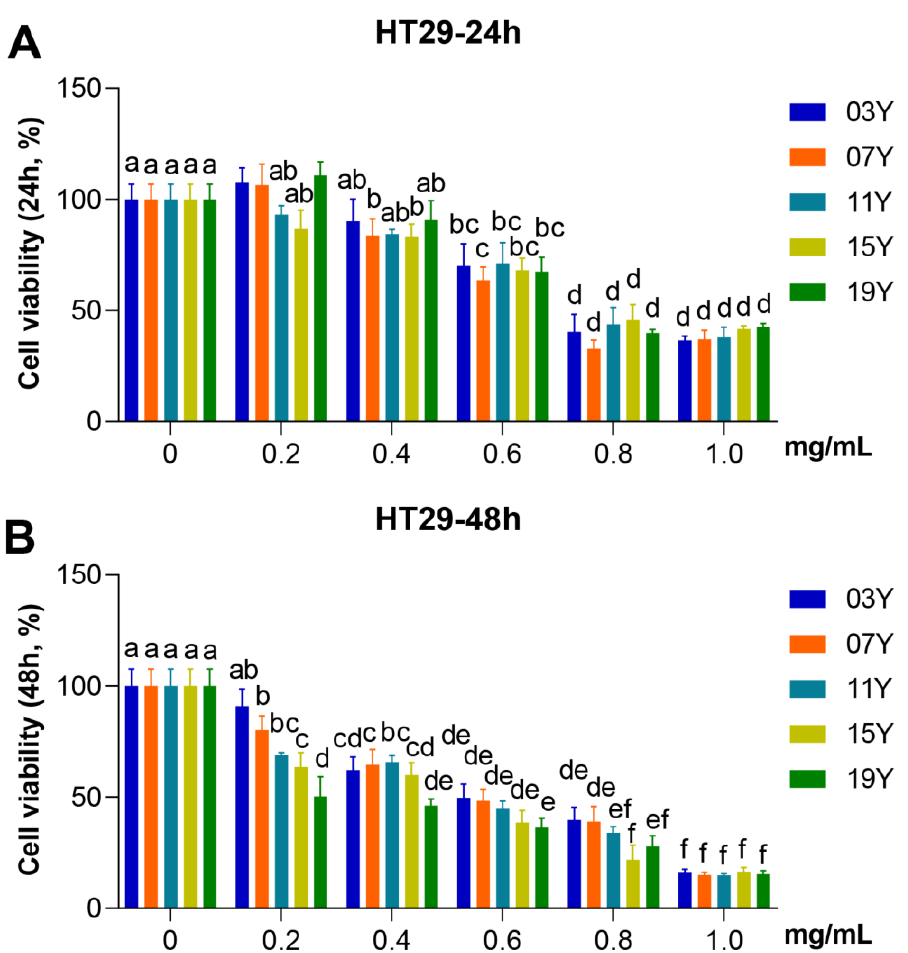
Figure 1. Inhibitory activity of HSGT extracts with various storage years on HT-29 cell viability. HT- 29 cells were treated with 0, 0.2, 0.4, 0.6, 0.8 and 1.0 mg/mL extracts of the different tea samples 03Y , 07Y , 11Y , 15Y and 19Y for 24 ( A ) and 48 h ( B ), respectively. The cell viability was detected by MTT assay. One-way ANOVA analysis was performed between the treatments of multiple tea samples. The different lowercase letters (a, b, c, d, e, f) in the same group show the significant differences at p < 0.05 level.